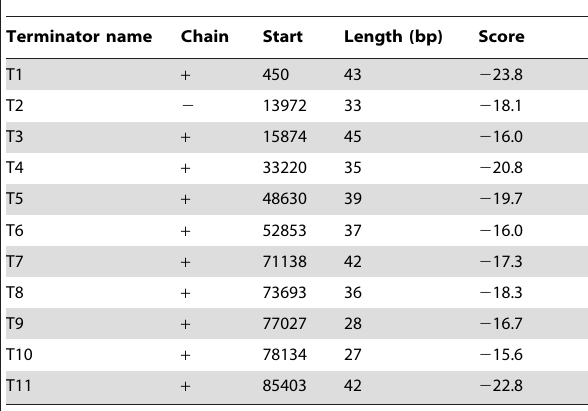
Table 3. Putative terminators of the PaP1 genome.